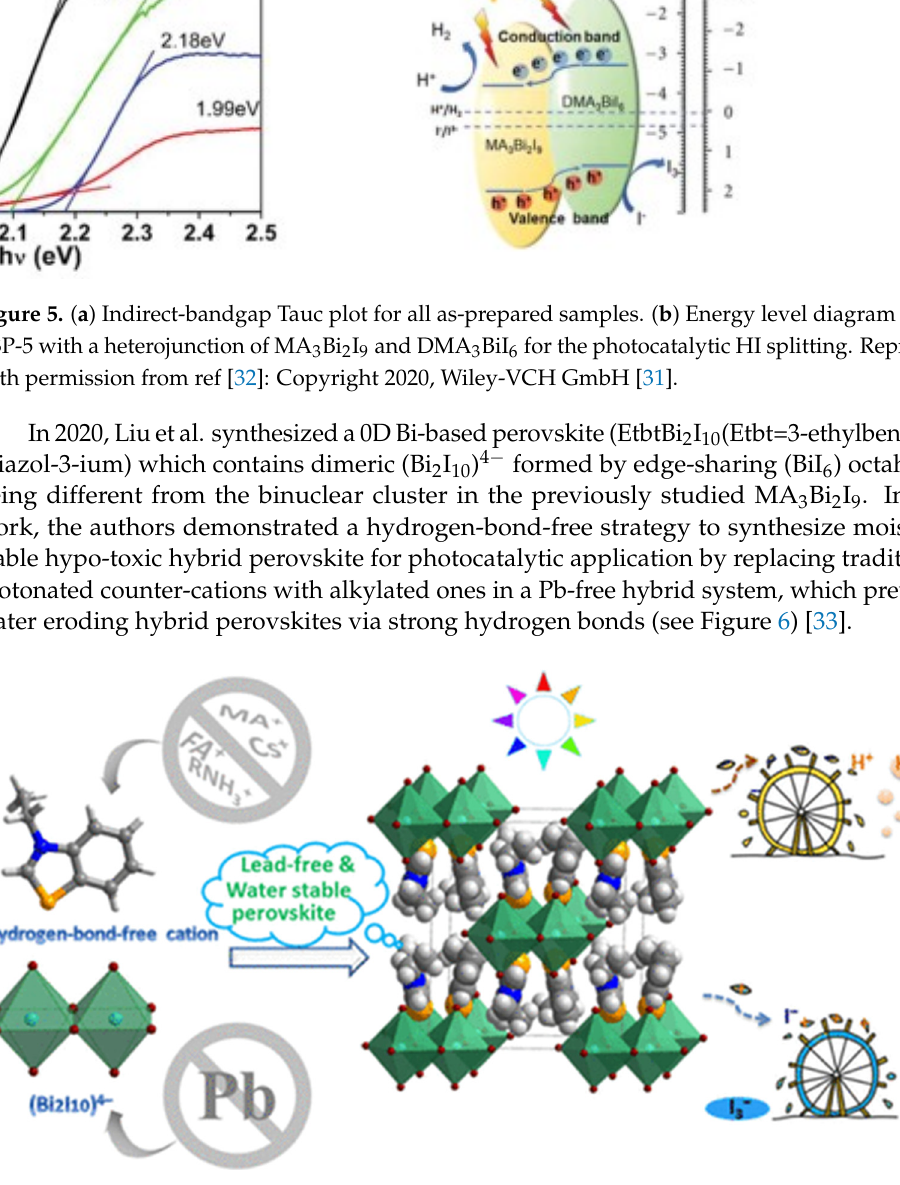
Figure 6. Zero-dimensional Bi-based perovskite (3-ethylbenzo[d]thiazol-3-ium) 4 Bi 2 I 10 photocatalytic mechanism schematic representation. Reprinted with permission from ref [33]: Copyright 2020, American Chemical Society [33].